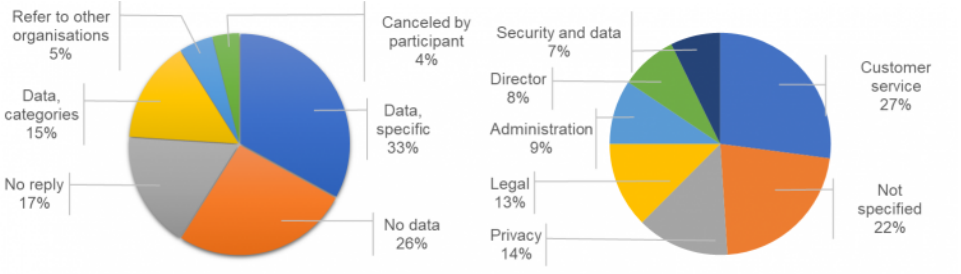
Figure 2: Response classification (left) & responding department (right) for total sample